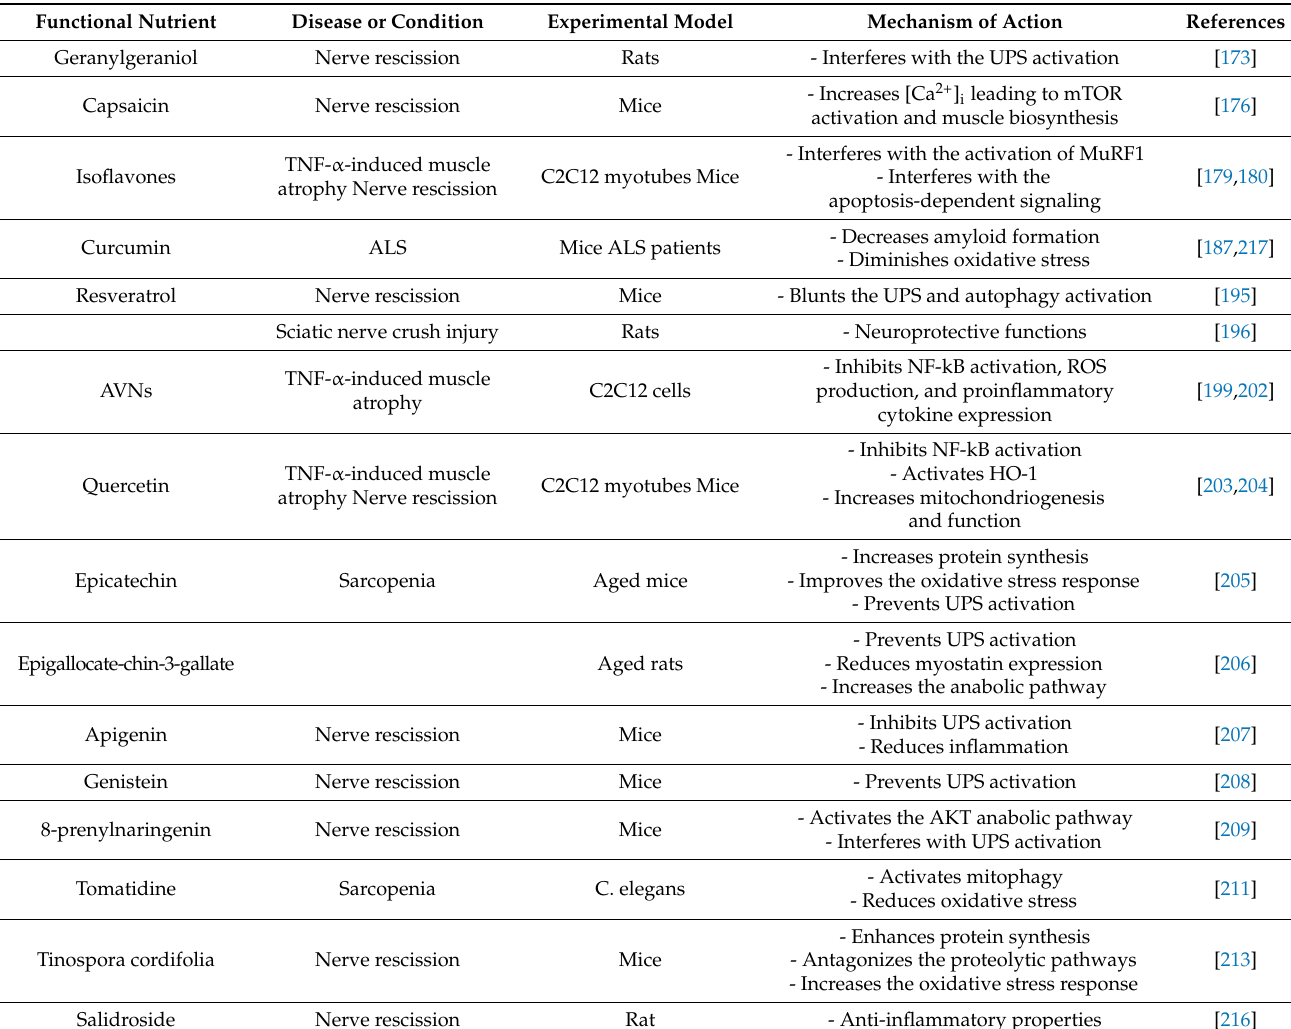
Table 4. Plant-derived ingredients effective on neurogenic muscle